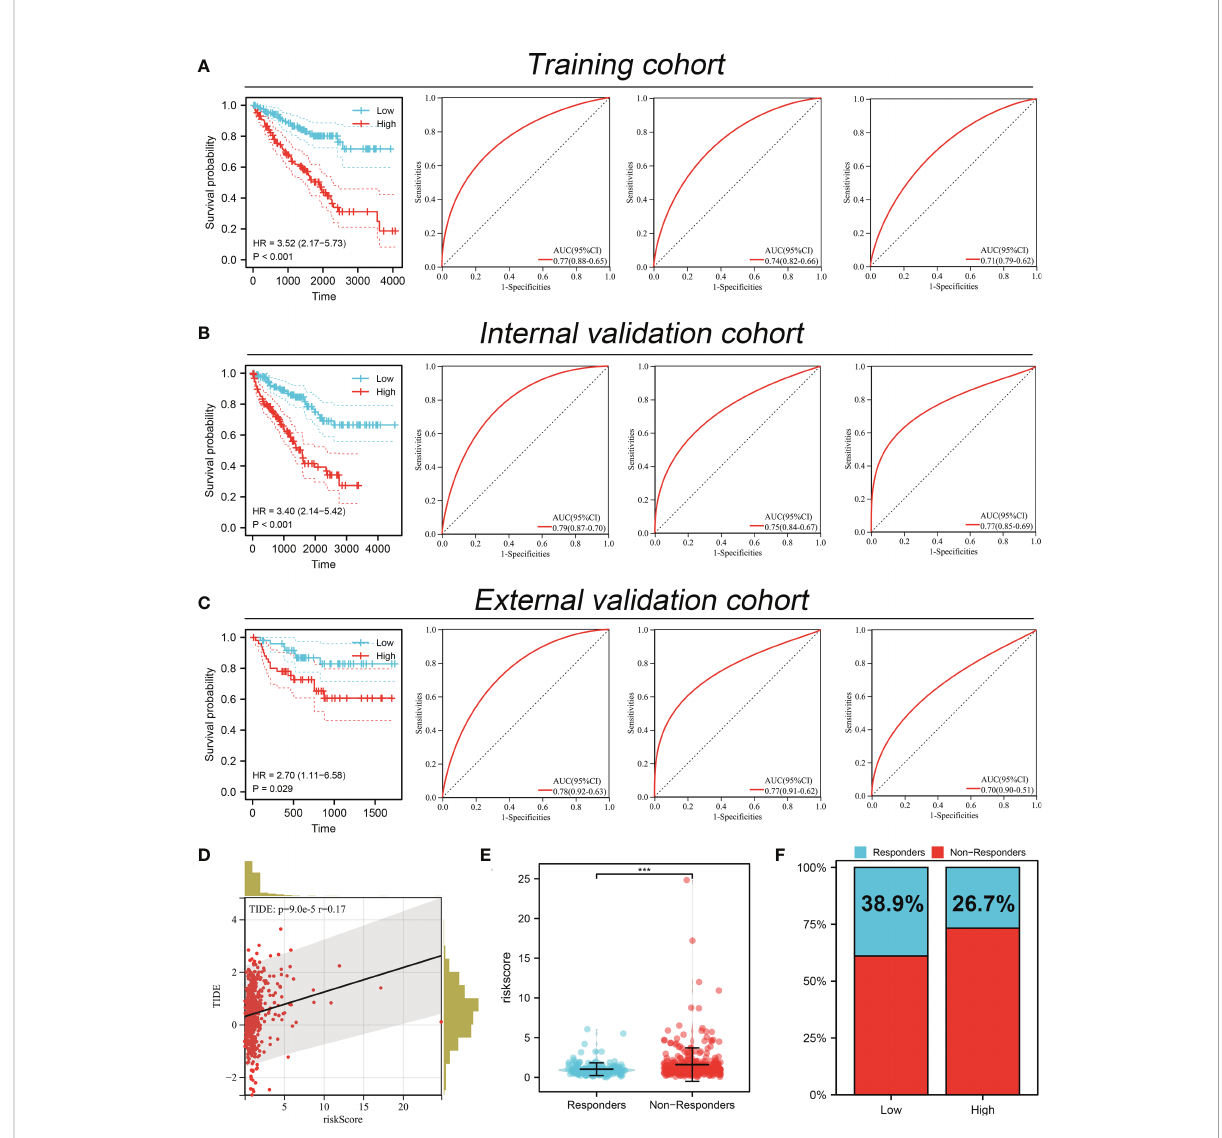
FIGURE 9 Performance of prognosis signature in predicting patients survival and immunotherapy. (A) The performance of our signature in predicting patients survival in the training cohort; (B) The performance of our signature in predicting patients survival in the internal validation cohort; (C) The performance of our signature in predicting patients survival in external validation cohort; (D) Correlation of risk score and TIDE; (E) The risk score level in immunotherapy responders and non-responders; (F) Percentage of immunotherapy responder in patients with high and low MYBL1 expression. ***P